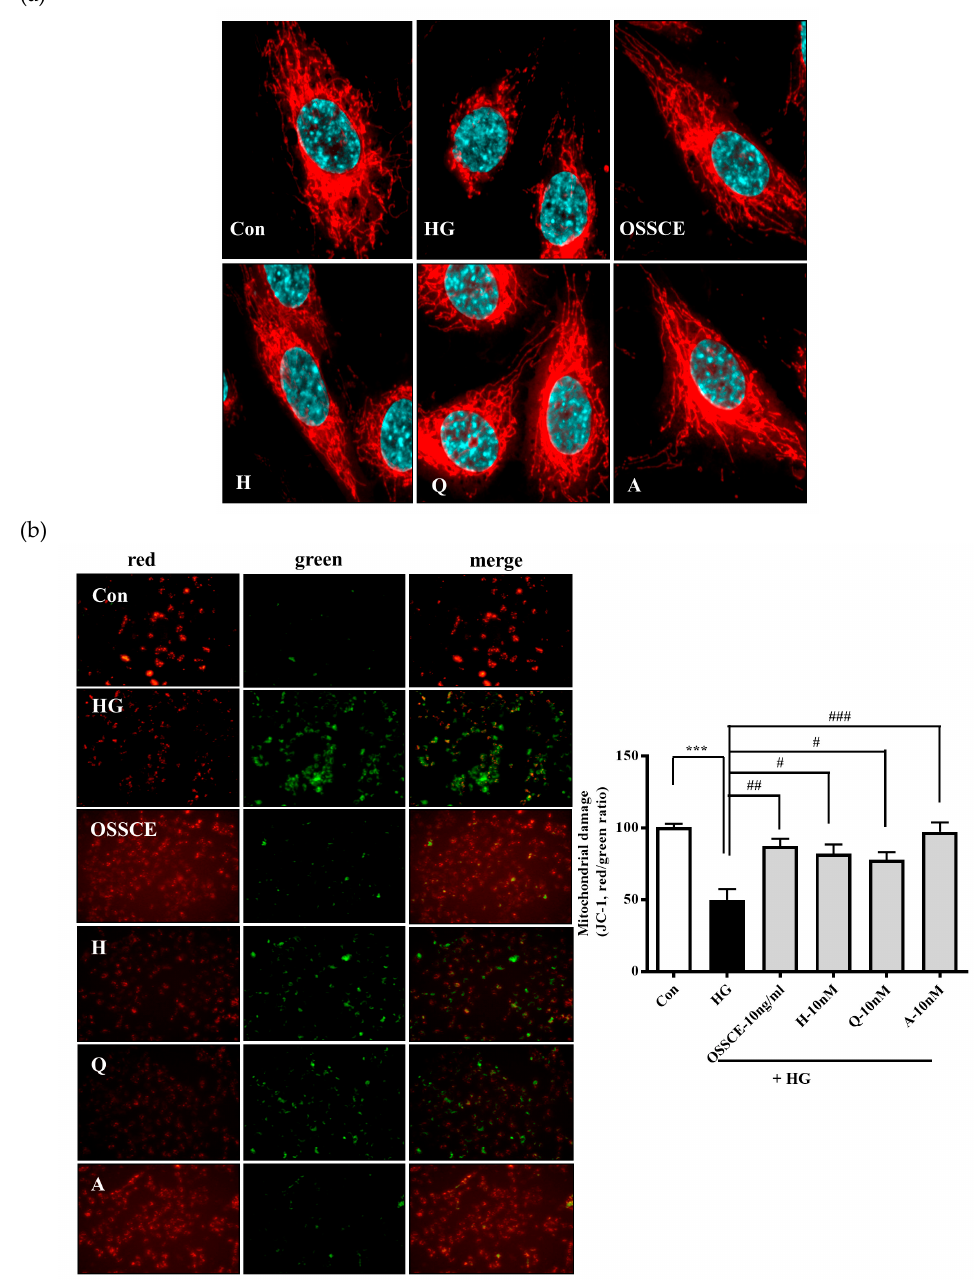
Figure 4. OSSCE and MCs inhibit the alteration of HG-induced mitochondrial morphology and mitochondrial membrane potential (MMP) activity in HRMECs. ( a ) OSSCE and MCs inhibit the alteration of mitochondrial shape in HG-induced HRMECs. ( b, left panel ) HRMECs were pre- incubated with OSSCE or MCs for 24 h in the absence or presence of HG, and then, the MMP was evaluated using JC-1. ( b, right panel ) The MMP was determined using an automatic fluorescence microplate reader. The MMP (ratio of red/green) activity in the OSSCE- and MC-treated groups showed significant increases compared with that in the HG-treated group, respectively. The red/green ratio ( ΔΨ m) of HG, OSSCE, H, Q, and A was 49.75 ± 15.49, 87.61 ± 9.59, 82.01 ± 13.22, 77.87 ± 10.38,